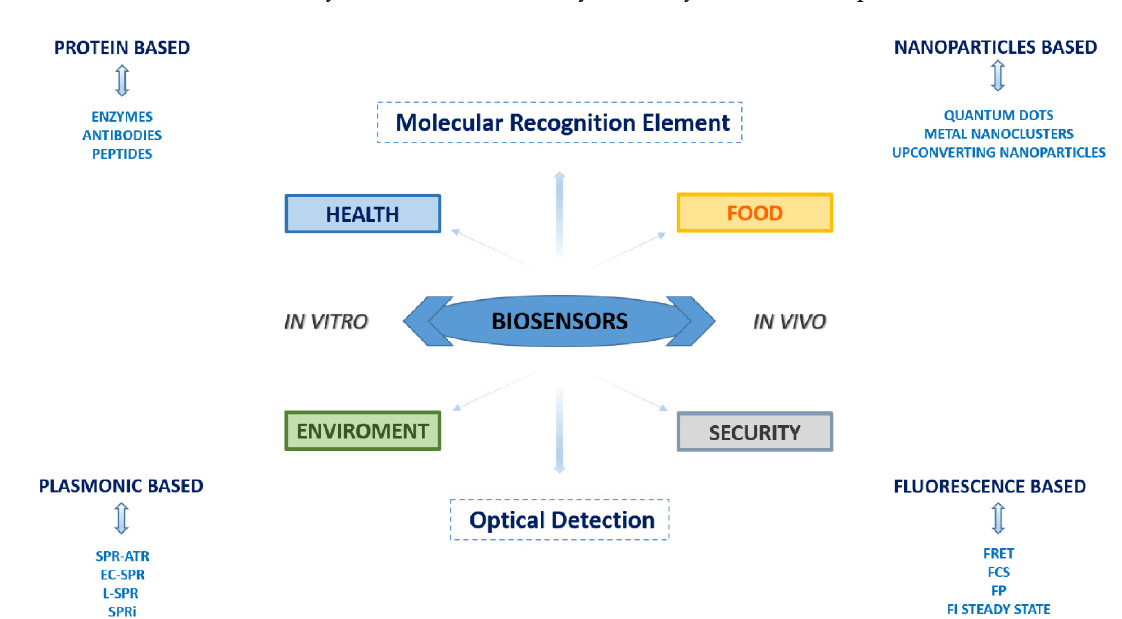
Figure 1. Schematic representation of the disclosed topics.